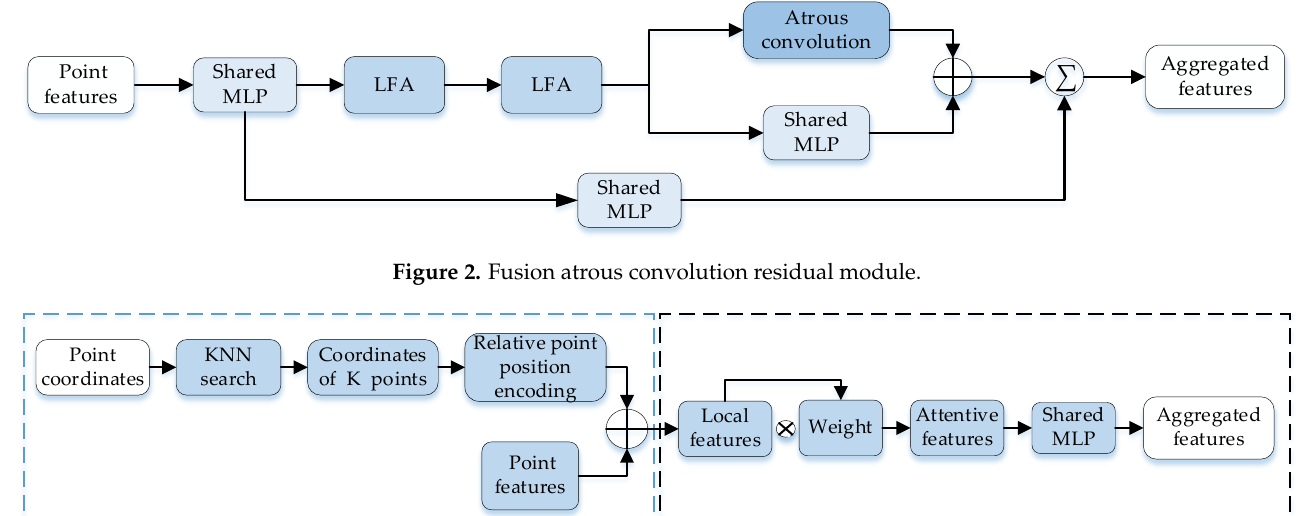
Figure 1. The framework of the proposed integrating normal vector features into an atrous convolution residual network. The input point clouds on the left are colored by elevation, and the output is the classification result.